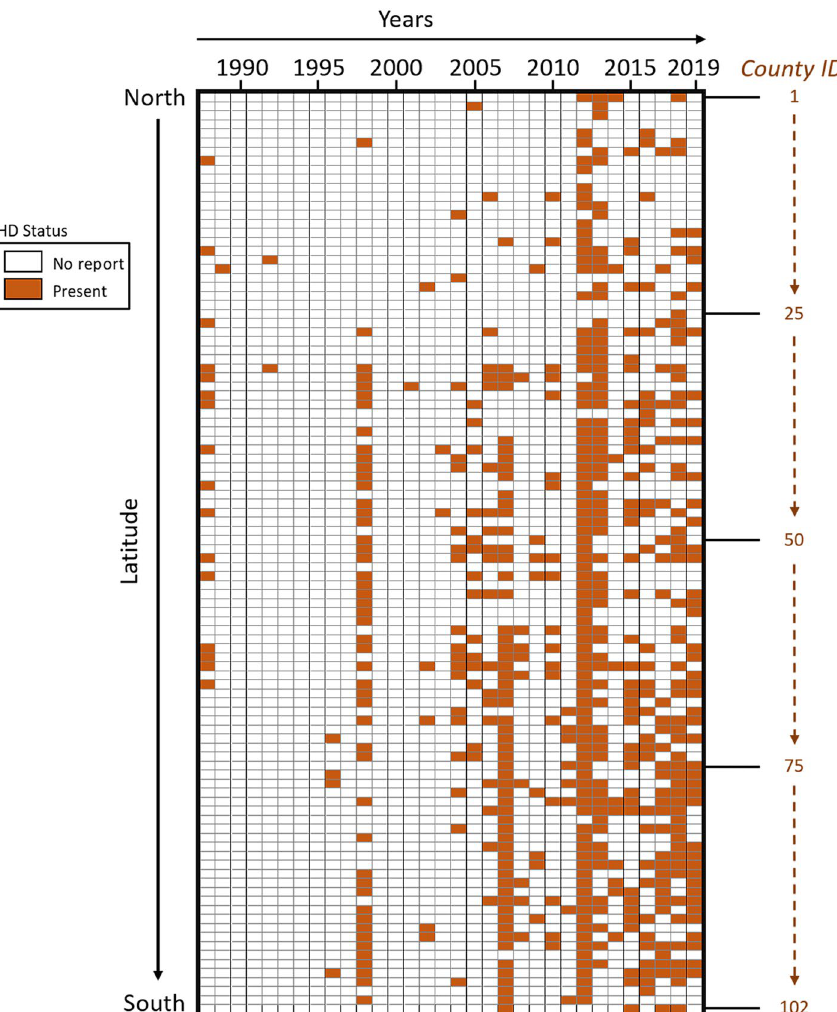
Figure 1. Hemorrhagic disease (HD) reports in wild white-tailed deer ( Odocoileus virginianus ) in the state of Illinois through time (1988–2019) by decreasing latitude. Individual cells in a column represent each county in the state of Illinois and are assigned a county ID 1–102; The ID number and county name are presented in Supplementary Figure